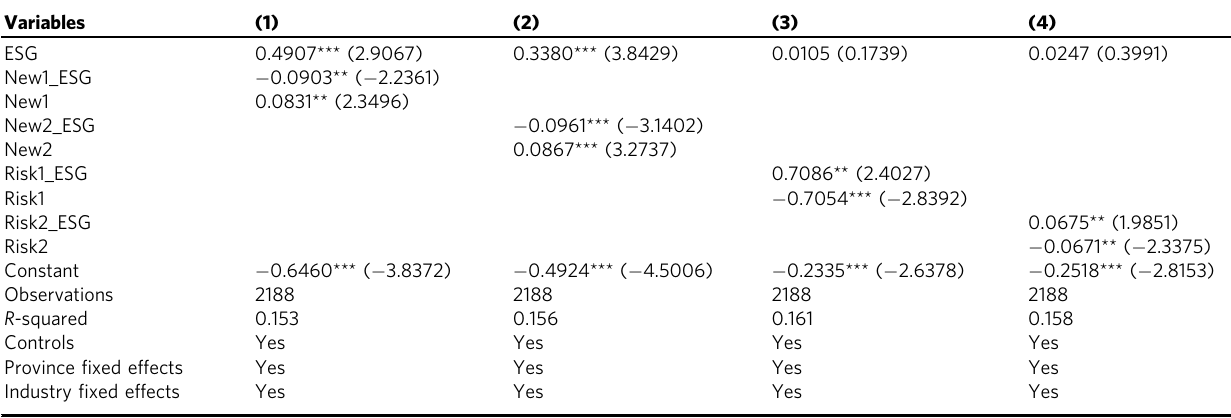
Table 6 Results of the mechanism